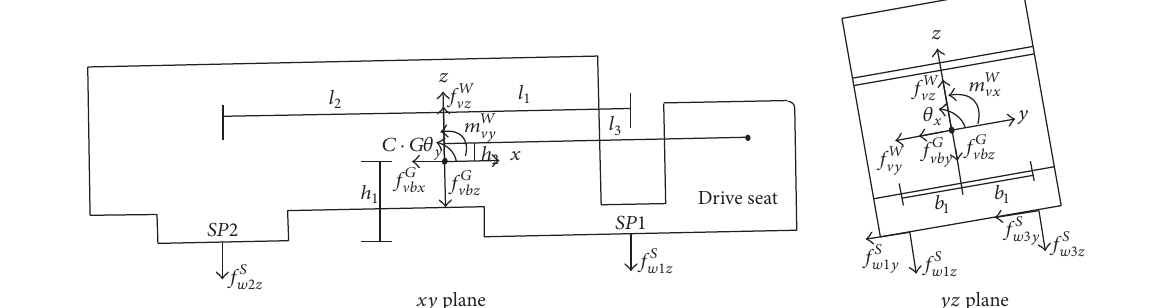
Figure 2: Force diagrams of vehicle